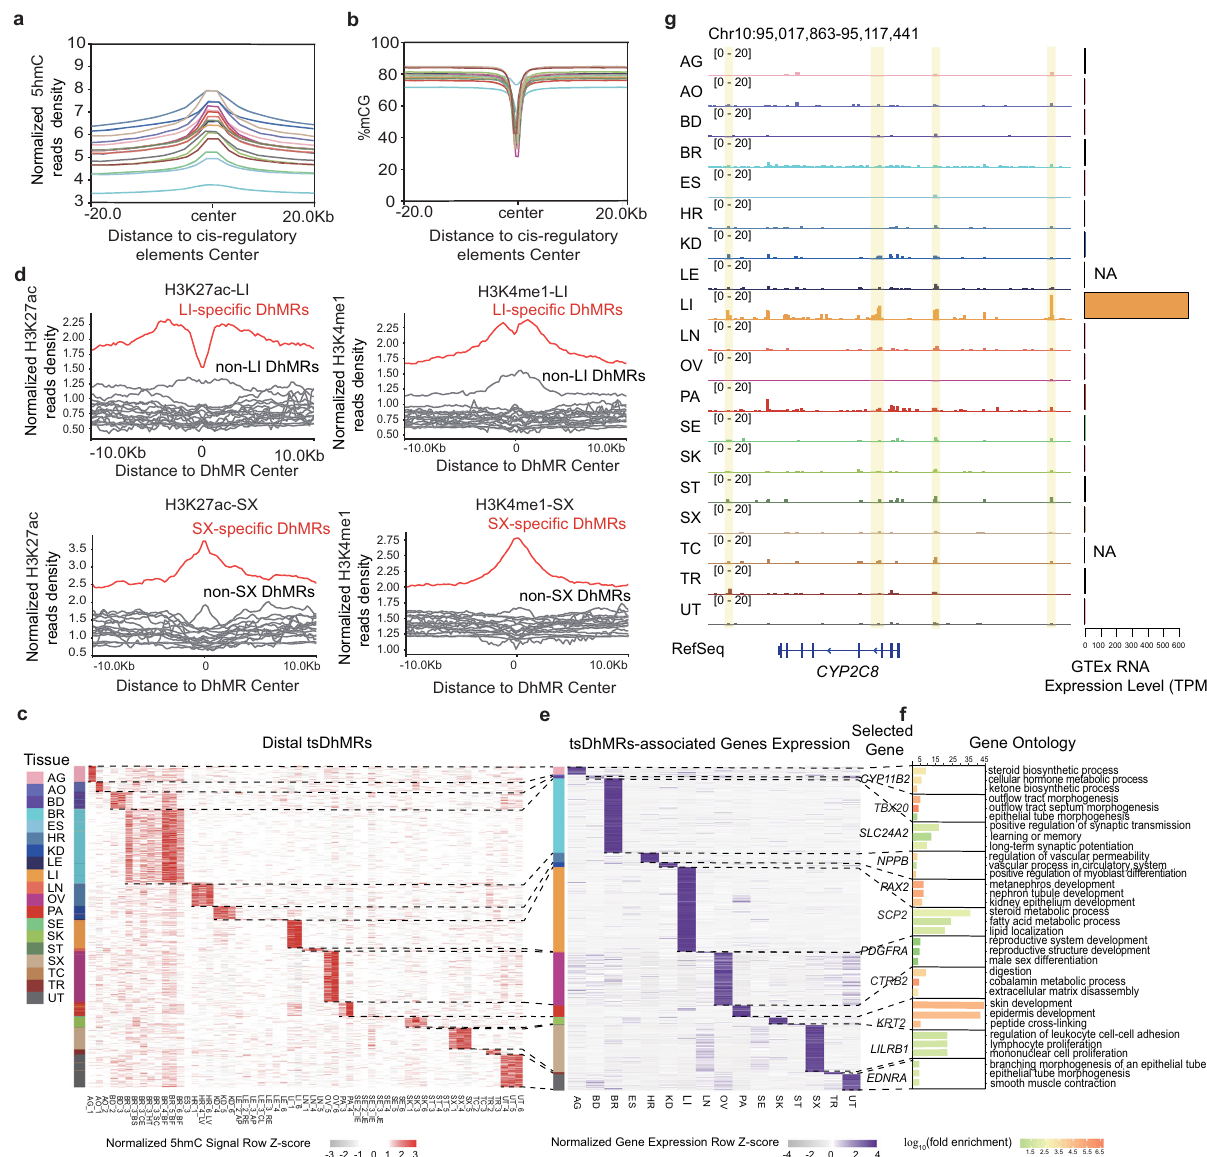
Fig. 4 tsDhMRs reside in regions with tissue-speci fi c regulatory elements. a , b Pro fi les of 5hmC ( a ) and 5mC ( b ) signals in their corresponding distal regulatory elements. The distal regulatory elements de fi ned by the ENCODE Project Consortium. c Heatmap showing the normalized 5hmC signals in distal tsDhMRs. d Pro fi les of H3K27ac and H3K4me1 modi fi cations around distal tsDhMRs in the liver (LI) and spleen (SX). Red represents the tissue type mentioned in the title of each panel and gray denotes the rest of the tissue types. e Heatmap showing the expression of genes associated with distal tsDhMRs within 500 kb. f GO enrichment and representative genes of distal tsDhMR-associated genes. g IGV visualization of the 5hmC signals near CYP2C8 on chromosome 10. The highlighted regions are liver-speci fi c